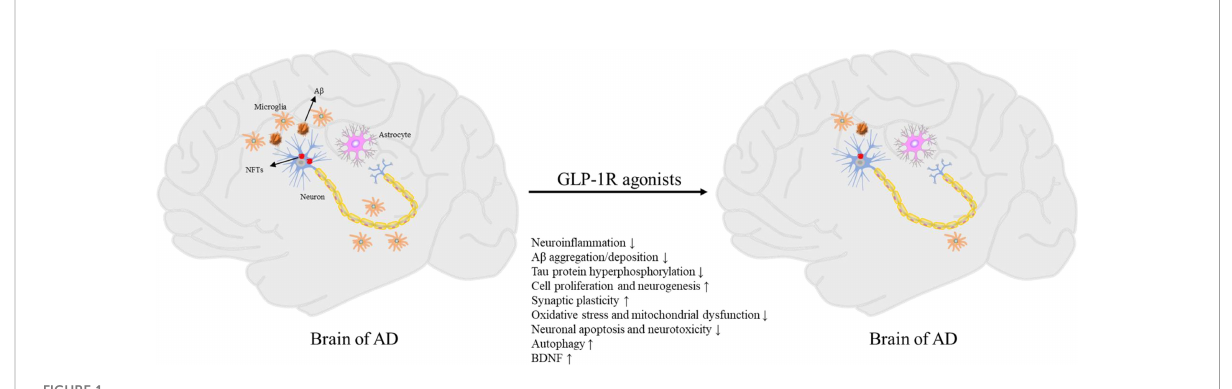
FIGURE 1 Pathogenesis of AD and neuroprotective effects of GLP-1R